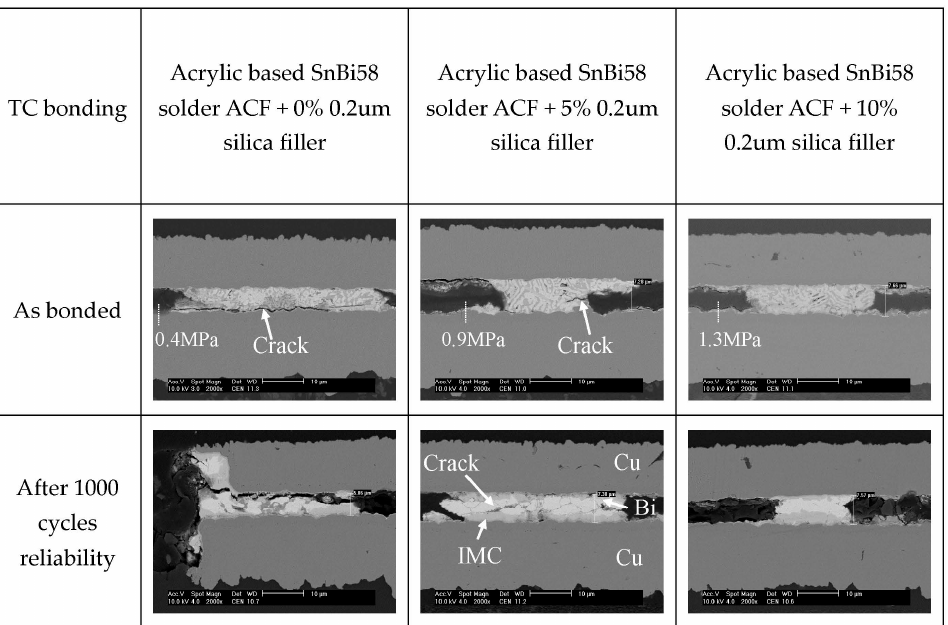
Figure 25. Solder joint morphologies of acrylic based SnBi58 solder ACFs added by 0, 5, and 10 wt % 0.2 μ m silica filler before and after 1000 cycles reliability test.